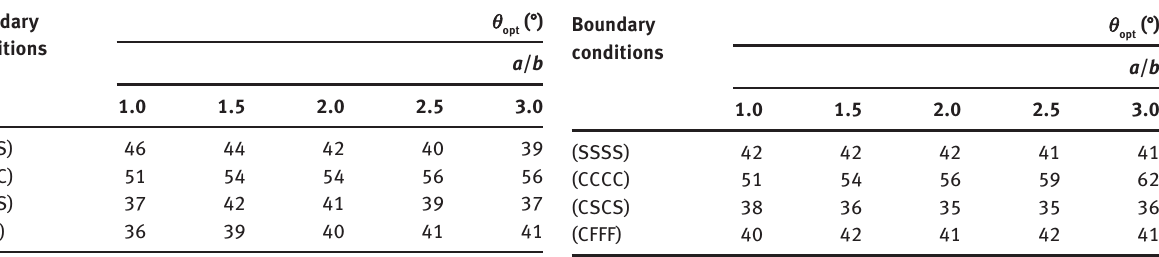
Table 1 Effects of a / b ratios and boundary conditions on the optimum fiber orientations for quadrilateral laminated plates.